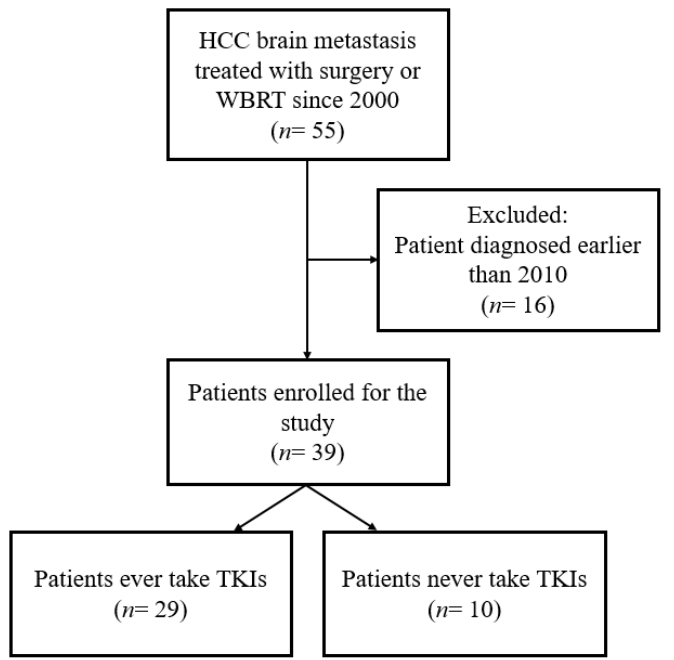
Figure 1. The flow diagram for patient enrollment. HCC: hepatocellular carcinoma; WBRT: whole- brain radiotherapy; TKI: sorafenib and lenvatinib.